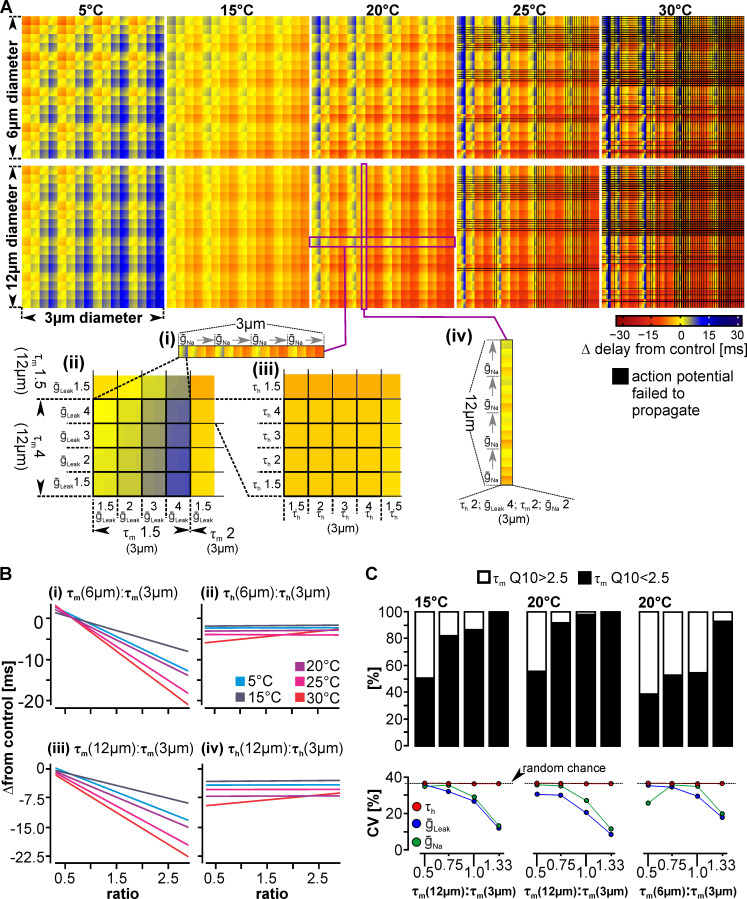
Timing between axons depends on the temperature-sensitivity of channel properties in small and large diameter axons.(A) Temperature-induced changes in AP timing between axons. The colors show how much AP arrival times change between axons at the axon terminal ('delay'). Delays were calculated in reference to the baseline temperature (10°C) for each axon and then as the difference (Δ) between two different diameter axons. Positive delays (blue) denote APs on the slower, smaller diameter axon arriving late. Conversely, negative delays (red) denote APs on the smaller diameter axon arriving earlier. Yellow colors indicate no or only small changes to AP timing between axons. At each temperature, all channel property Q10s of the 3μm axon are varied along the x-axis, with increasing Q10s from left to right. On the y-axis, all channel property Q10s of the 6μm (top) and 12μm (bottom) axon are varied, with increasing Q10s. The bottom insets (i-iv) give the details of which properties were nested inside each other, and how they were varied. (i—iii) Example of 16 variations of ion channel property Q10s in the 12μm axon (vertically, gNa = 2, τm = 4, gleak = 1.5–4, τh, = 1.5–4). From left to right, all Q10 combinations of the 3μm axon are shown (i), and then a subset of them (ii, iii). (iv) Example of how changes to the 12μm axon affect the delay with respect to a single 3μm axon (τh, = 2, gleak = 4, τm = 2, gNa = 2). (Bi-iv) Delay as a function of the ratio between ion channel property Q10s in both axons, representing the best (Sodium channel activation gate time constant, τm) and the worst predictors of timing (Sodium channel inactivation gate time constant, τh). Ratios were calculated by dividing the larger axon by the smaller. (C, top) The percentage of models that achieve temperature-robust timing with high Sodium channel activation gate time constant (τm) Q10s depends on ratio of τm between the two axons, the temperature, and difference in axon diameter. (C, bottom) When the Sodium channel activation gate time constant Q10 is constrained to either high or low values, the coefficient of variation (CV) of the maximum leak and Sodium conductances (blue and green respectively) decreased from random chance (dotted line), indicating that coordinating these channel properties becomes more important for maintaining robust timing.